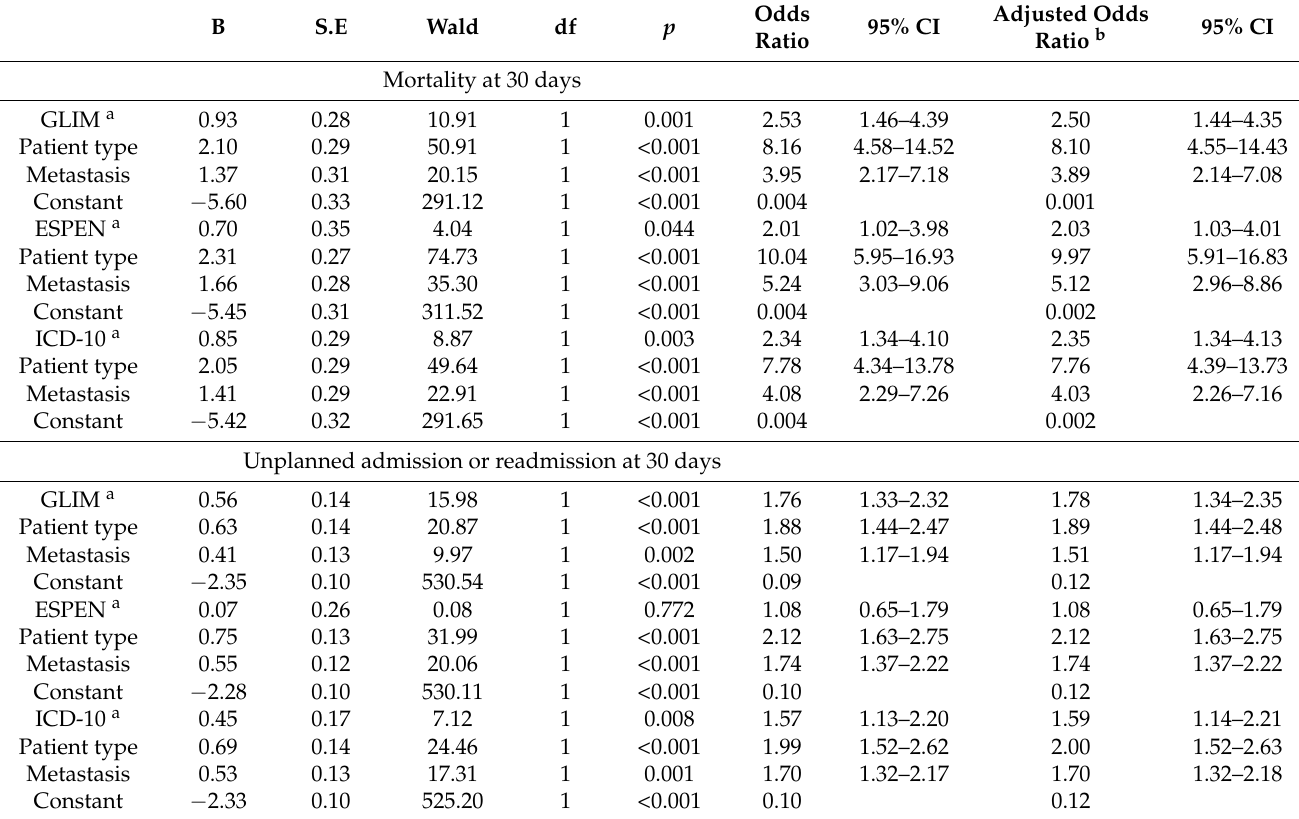
Table 4. Multivariate logistic regression of the association between GLIM, ESPEN and ICD-10 malnutrition diagnosis and mortality/unplanned admission or readmission at 30